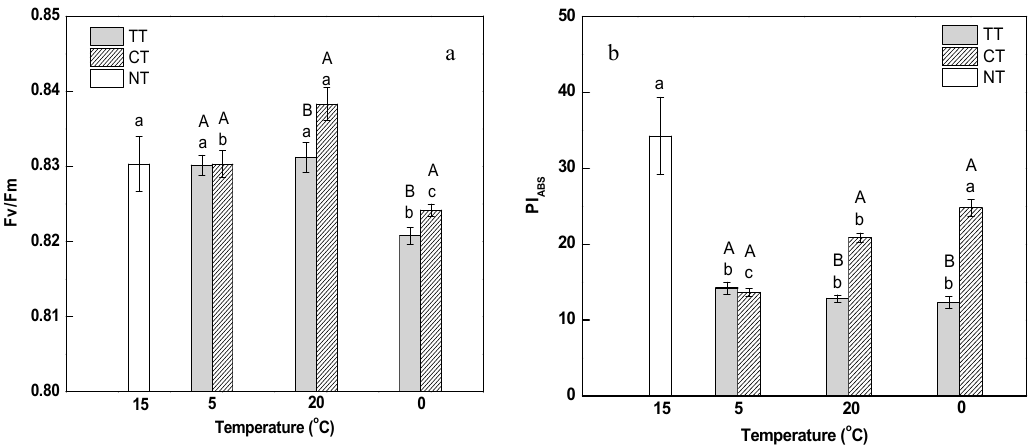
Figure 3. Effect of calcium on maximal photochemical efficiency of Photosystem II (Fv/Fm) ( a ) and performance index on absorption basis (PI ABS ) ( b ) in M. baccata leaves under temperature stress. TT, temperature treatment; CT, calcium treatment; NT, control. Lowercase letters above the bars indicate significant difference at p < 0.05 (Duncan’s test) of different treatments at the same temperature. Capital letters above the bars indicate significant difference at p < 0.05 (Duncan’s test) of the same treatment at different temperature.